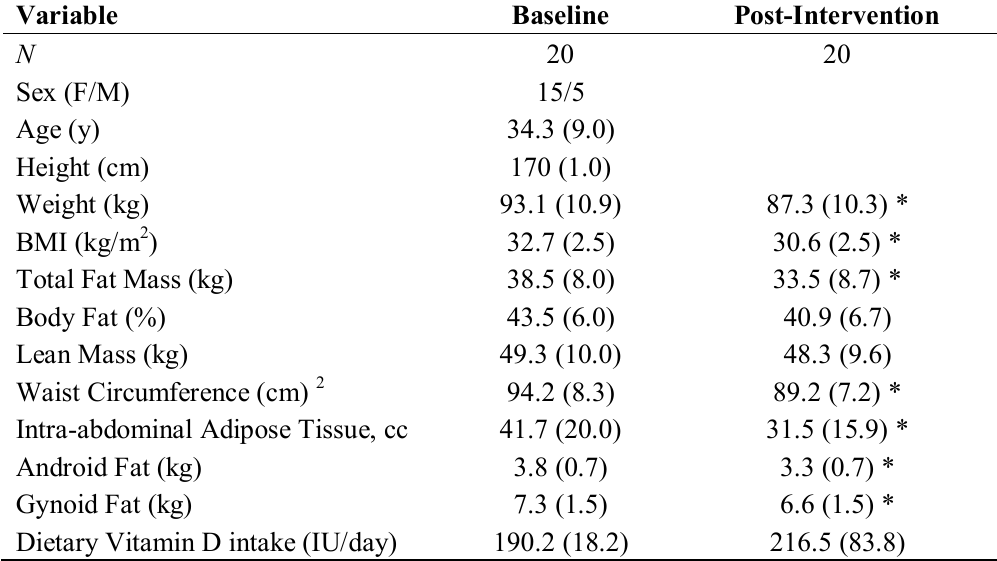
Table 1. Subject characteristics at Baseline and Post-Intervention 1